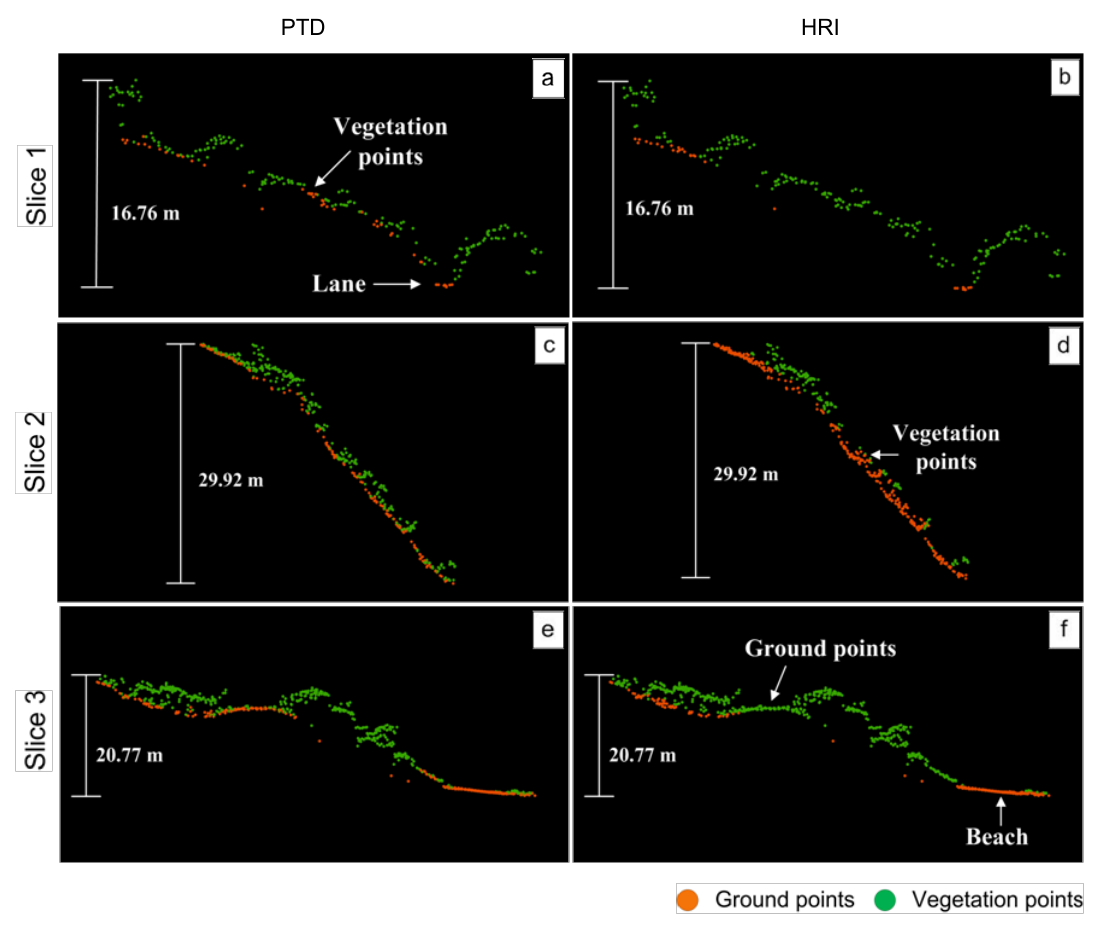
Figure 2. Filtering and classification results of two algorithms (PTD and HRI) for three vertical slices of LiDAR point